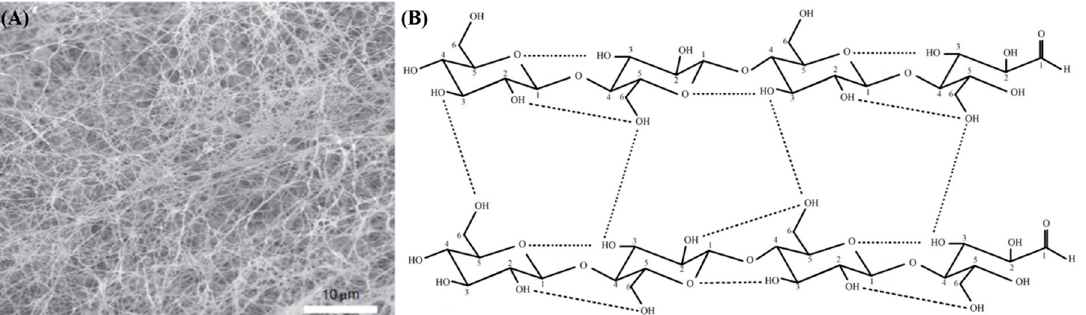
Figure 1. ( A ) SEM image of bacterial cellulose’s nanostructure and ( B ) Inter- and intra-hydrogen bonding of bacterial cellulose [22,23] . Copyright 2017 and 2014 Elsevier Ltd.